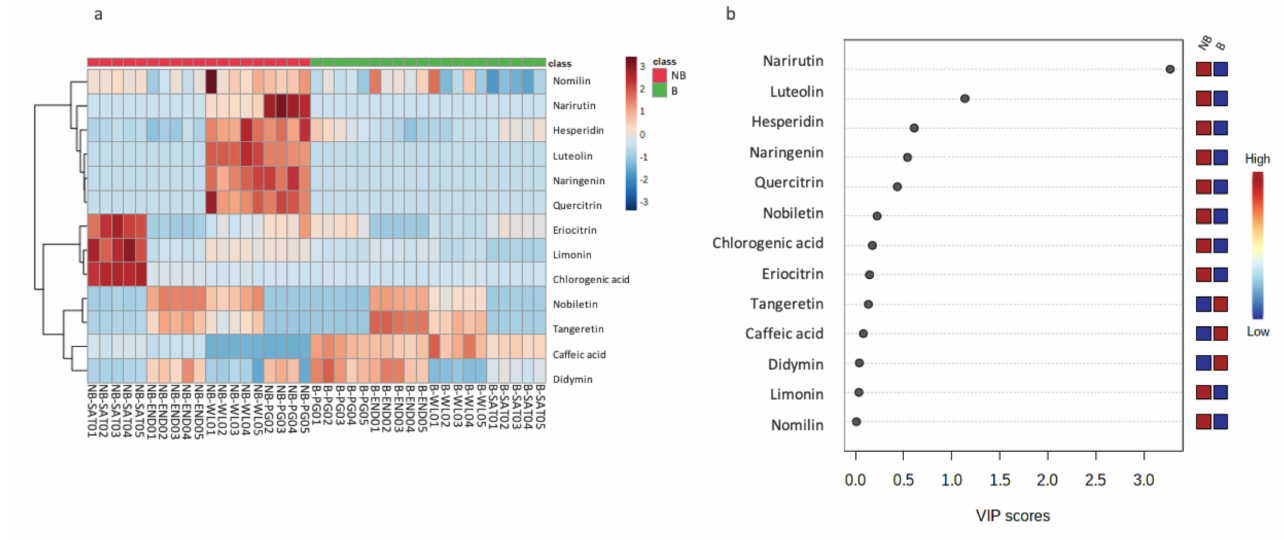
Figure 5. ( a ) Heatmap of bearing and non-bearing leaf samples of the four varieties of mandarin: ‘Ellendale’ (END), ‘Willowleaf’ (WL), ‘Page’ (PG), and ‘Satsuma’ (SAT); ( b ) VIP scores of the PLS-DA performed to identify the metabolites that differentiate between both bearing